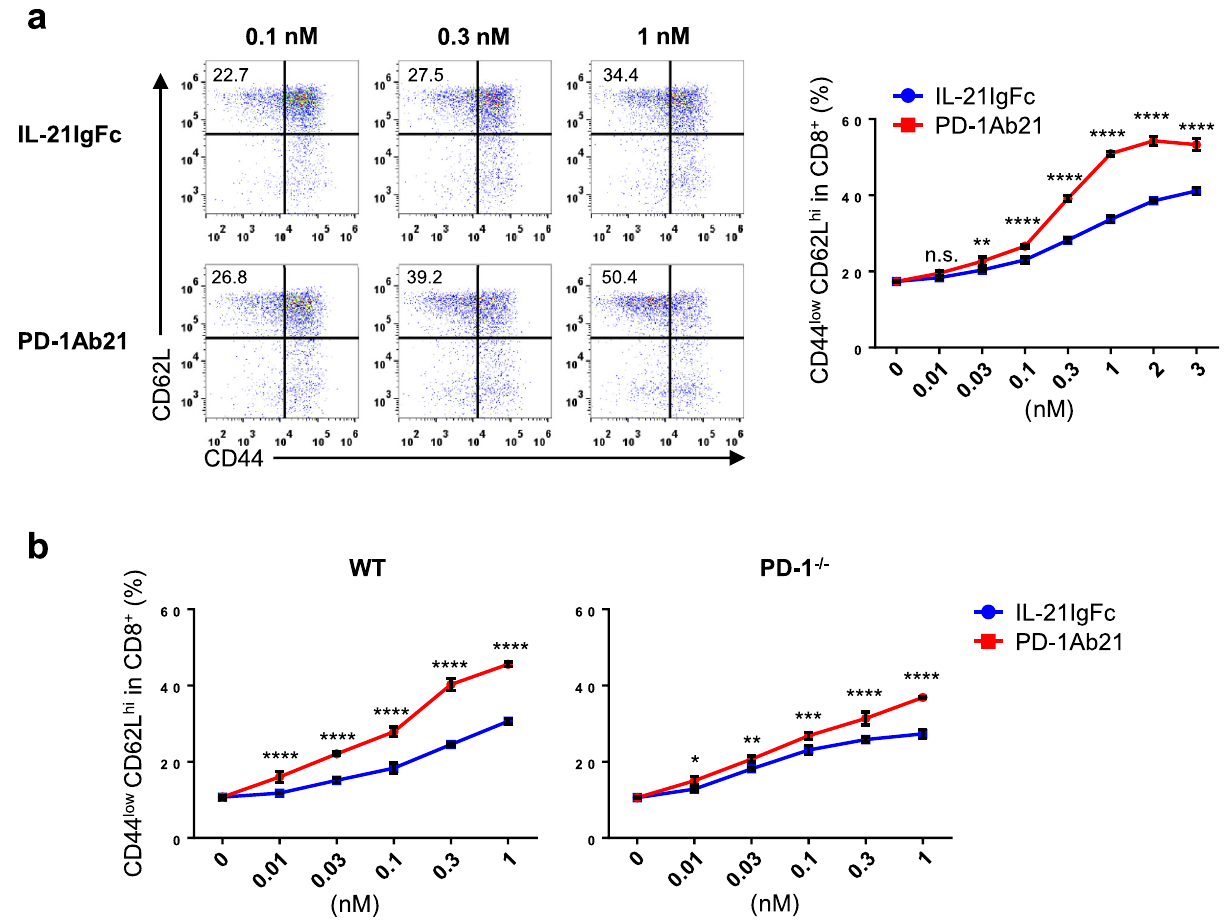
Fig. 4 Targeting effects of PD-1Ab21 on differentiation of T SCM -like cells by binding to PD-1 + T cells. a , b Naïve OT-1 cells were activated by OVA 257-264 peptide for 2 d and then differentiated with different concentrations of cytokines or proteins for 3 d. T cell differentiation was analyzed by fl ow cytometry. a Representative dot-plots of T SCM differentiation with different concentrations of IL-21IgFc and PD-1Ab21 (left). Percentage of CD44 low CD62L high CD8 + T cells was counted (right). b Naïve T cells isolated from LNs of WT or PD-1 − / − mice were primed with anti-CD3 and anti-CD28 for 2 d, and then differentiated with the indicated concentrations of IL-21IgFc or PD-1Ab21. Percentage of CD44 low CD62L high CD8 + T cells was counted. All data are presented as mean ± SD and representative of at least three independently performed experiments. Results were compared using two-way ANOVA followed by Tukey ’ s multiple comparison test. a ** p = 0.0086. **** p < 0.0001. b * p = 0.0257, ** p = 0.0082, *** p = 0.0001, **** p < 0.0001, n.s. not signi fi